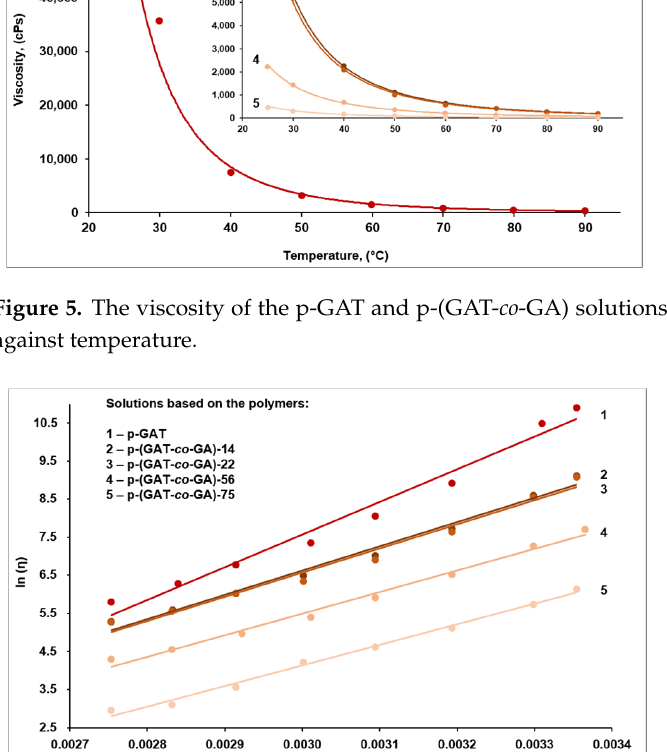
Figure 6. A plot of ln ( η ) versus inverse temperature (1/T) for the p-GAT and p-(GAT- co -GA) solutions in the HET plasticizer.